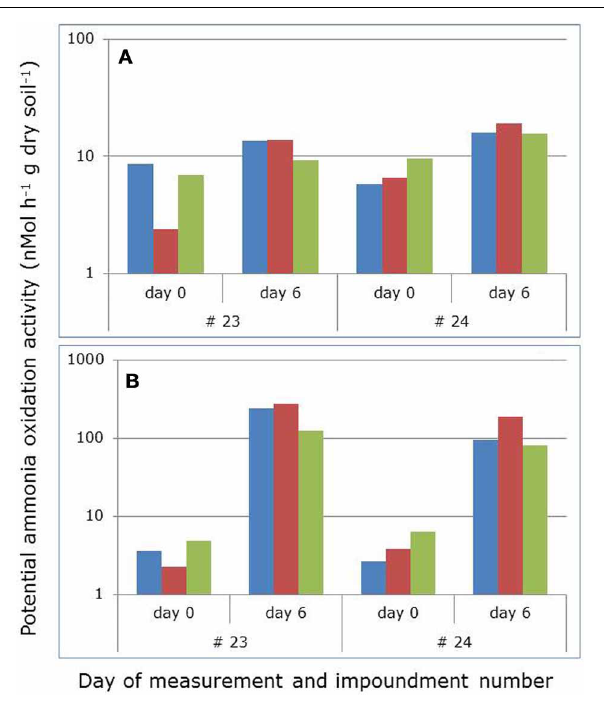
FIGURE 1 | Average potential ammonia-oxidizing activities in mangrove soil slurries before and after prolonged incubation of 6 days with added ammonium in the absence (A) and presence (B) of continuously shaking of the slurries. Soils had been collected in 2009 and 2010 in two different impoundments (23 and 24) from three different habitats characterized by stunted (blue), sparse (red), and dense (green) Avicennia germinans . Both in 2009 and in 2010, incubation increased the potential activities significantly ( p = 0 . 0039 and p = 0 . 0000, respectively; non-parametric Kruskal-Wallis test with N = 60 and H = 8 . 344 and H = 27 . 876, respectively). No significant effects between years, impoundments, and vegetation cover types were observed.